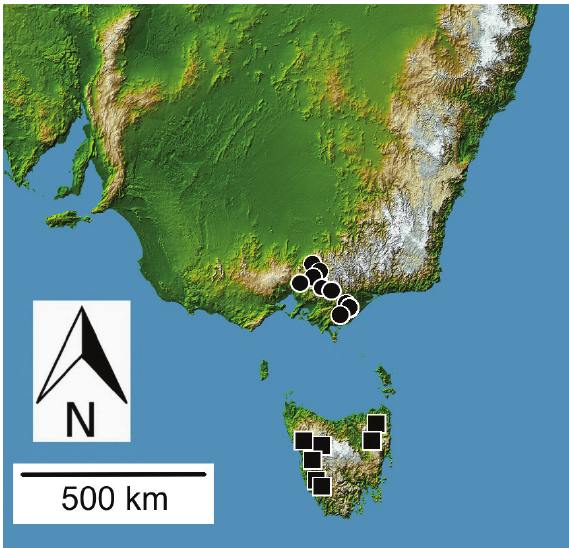
Figure 10. Distributional records for Theprisa spp.: T. australis (circle);  T. darlingtoni (square).